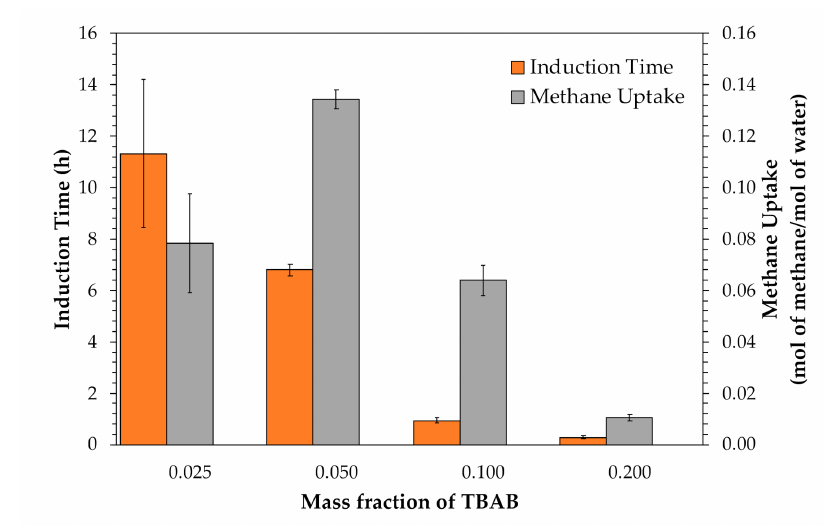
Figure 2. E ff ects of TBAB concentrations (mass fraction) on the induction time and methane